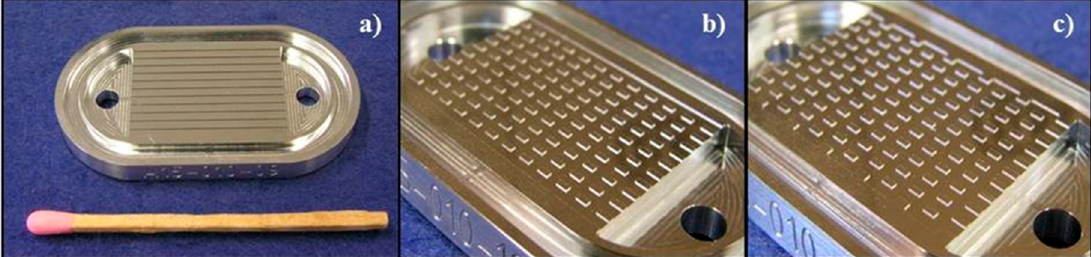
Figure 2. Microstructures made of aluminum: ( a ) straight micro channels, ( b ) parallel pins, and ( c ) staggered pins. The microstructures were positioned on an area of W × L = 0.0173 m × 0.0235 m with a height of H = 0.0001 m. The active volume was calculated based on the total free flow area, namely the volume in front, behind, and in between each pin fin was summed to estimate the active volume. Similar calculations were used to estimate the total heat transfer area of each device based on the area through which the heat is transferred. Due to the varying number of pin fins and their arrangement, the active volume and the heat transfer area are different for each microstructure arrangement.